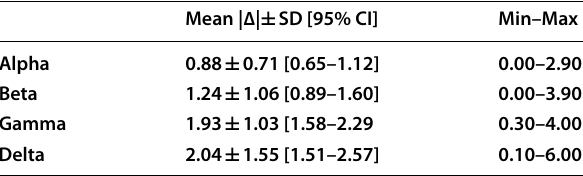
Table 1 Accuracy of ROSA to reproduce intra-operative plan for bone resection